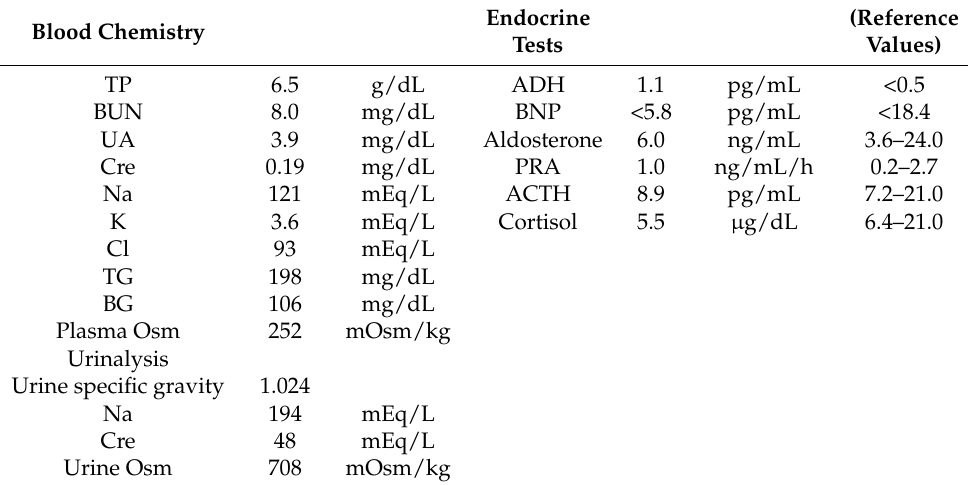
Table 1. Laboratory data in hyponatremia before the